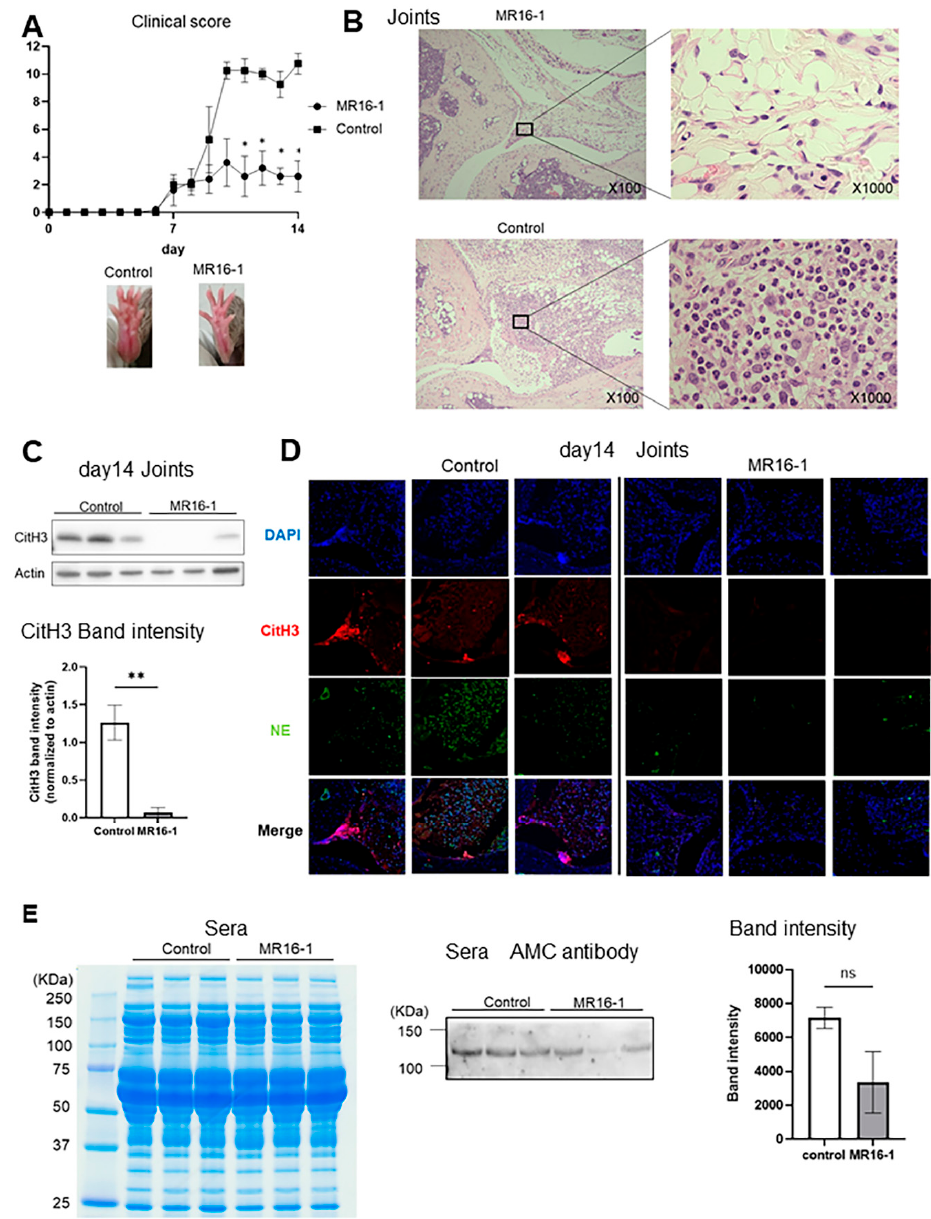
Figure 3. Suppression of arthritis obtained by treatment with MR16-1 in pGIA mice. ( A ) Clinical scores (means ± SEMs) of pGIA mice treated with MR16-1 (n = 5) or control IgG (n = 4), and representative images of ankle joints of pGIA and control mice. p values were calculated using two-way ANOVA with the post hoc Sidak multiple comparisons test. ( B ) Representative images of hematoxylin–eosin staining of pGIA joints treated with MR16-1 or control IgG. ( C ) Western blot analysis of the joint lysates of pGIA mice treated with MR16-1 or control IgG using anti-CitH3 antibodies. Three mice in each group were analyzed. Bars show means ± SEMs. p values were calculated using the unpaired t -test; ** p < 0.01. ( D ) Immunofluorescence using anti-CitH3 antibodies and anti-NE antibodies were performed on joint sections from the pGIA mice treated with MR16-1 and from the control mice (representative images from 3 mice in each group). DAPI was used for DNA staining. ( E ) Sera from pGIA mice treated with MR16-1 and control IgG were separated by SDS-PAGE then stained with Coomassie brilliant blue (CBB) or subjected to Western blot analysis using anti-modified citrulline antibodies. Three mice in each group were analyzed. p values were calculated using the unpaired t